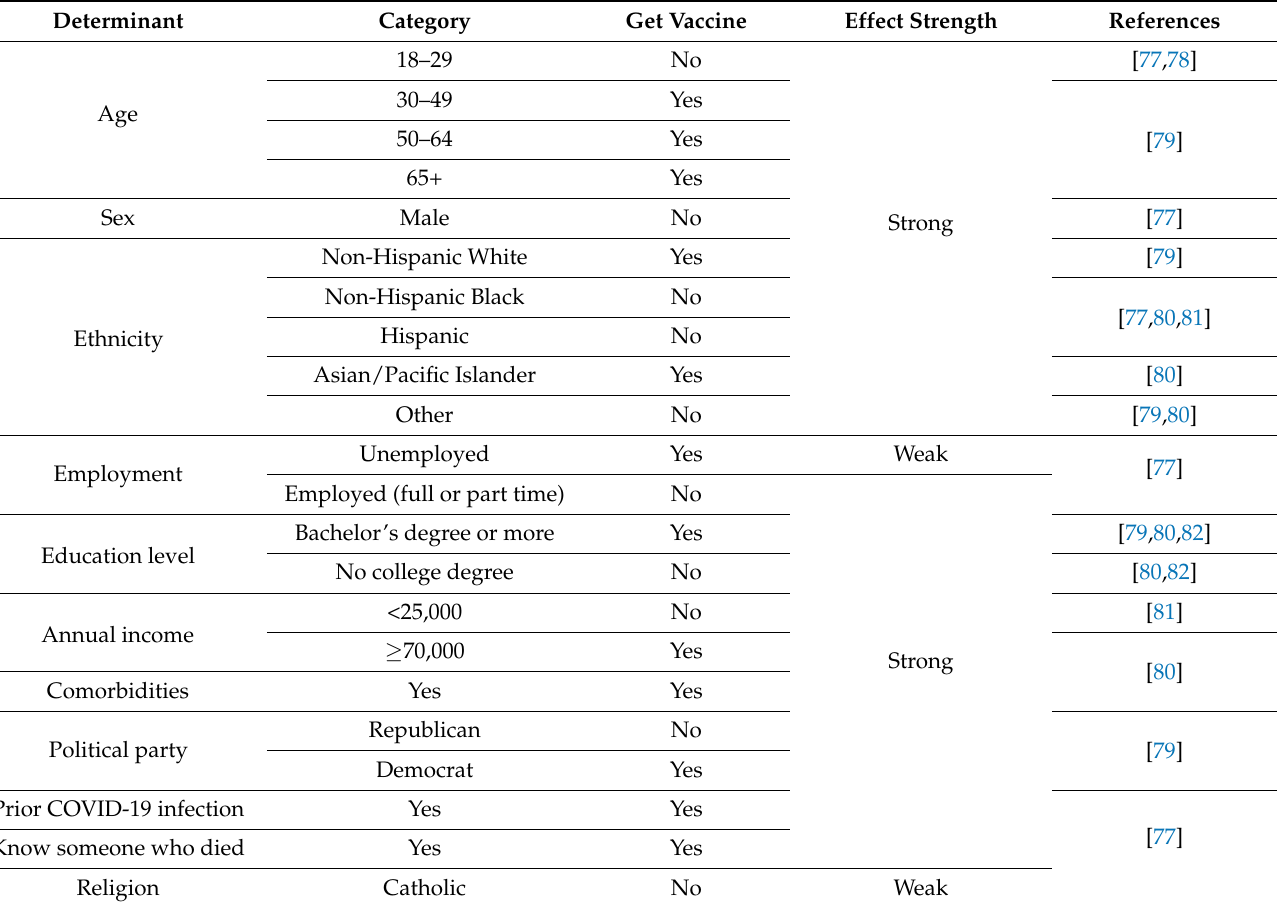
Table 2. Propensity of U.S. individuals in specific socio-demographic categories to get vaccinated or not, and strength of the effect as reported in the references. We counted a reduction in refusal as being equivalent to an increase in acceptance